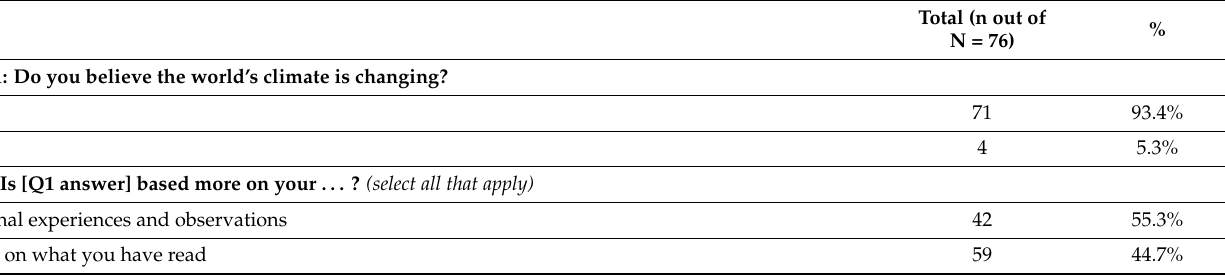
Table 4. List of questions and answers to a portion of the “Climate Change Awareness Survey” by the Student Conservation Association, as adapted by